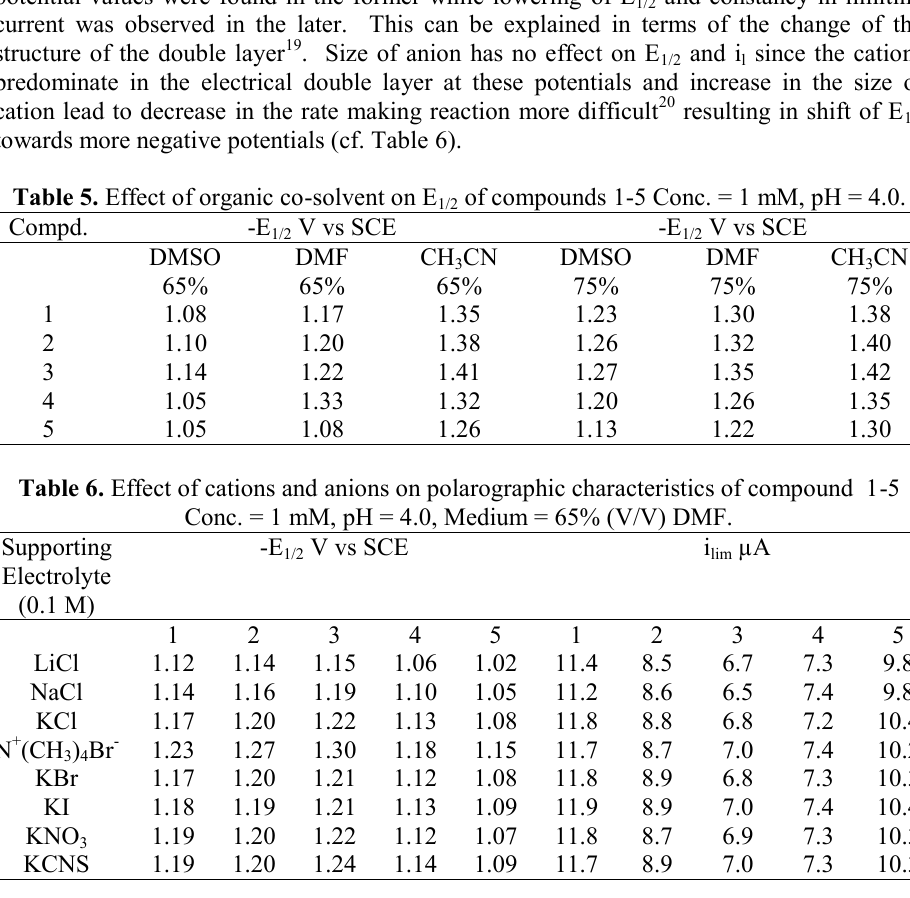
Table 5. Effect of organic co-solvent on E Compd.